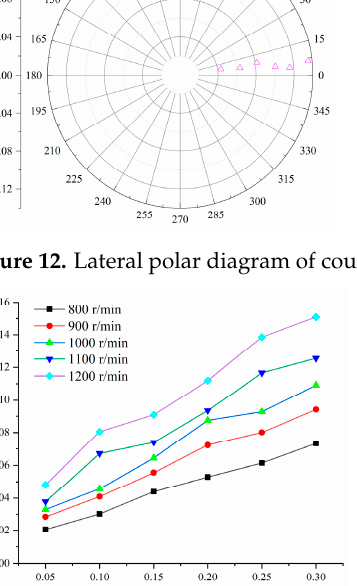
Figure 13. Longitudinal amplitude diagram of counterweight.